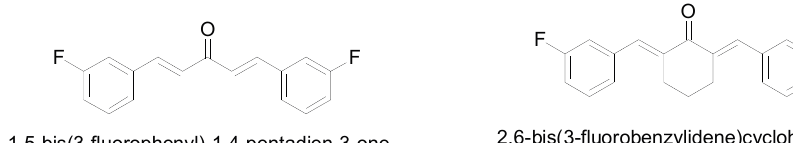
Figure 1. Molecular structures of diarylpentanoid